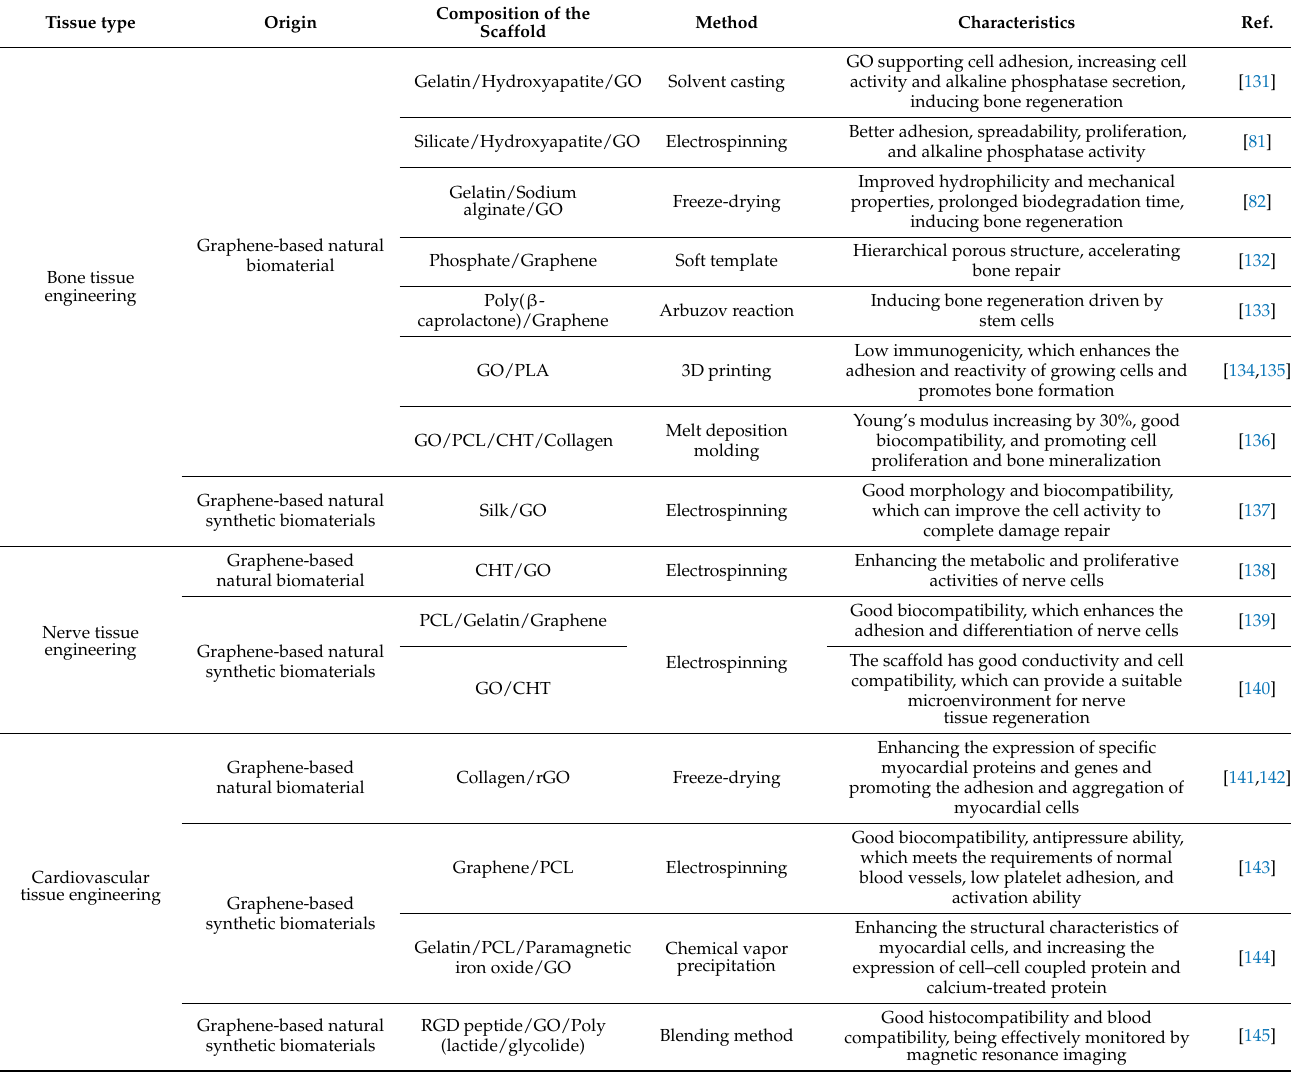
Table 1. Application of graphene-based composite scaffolds in different tissue engineering